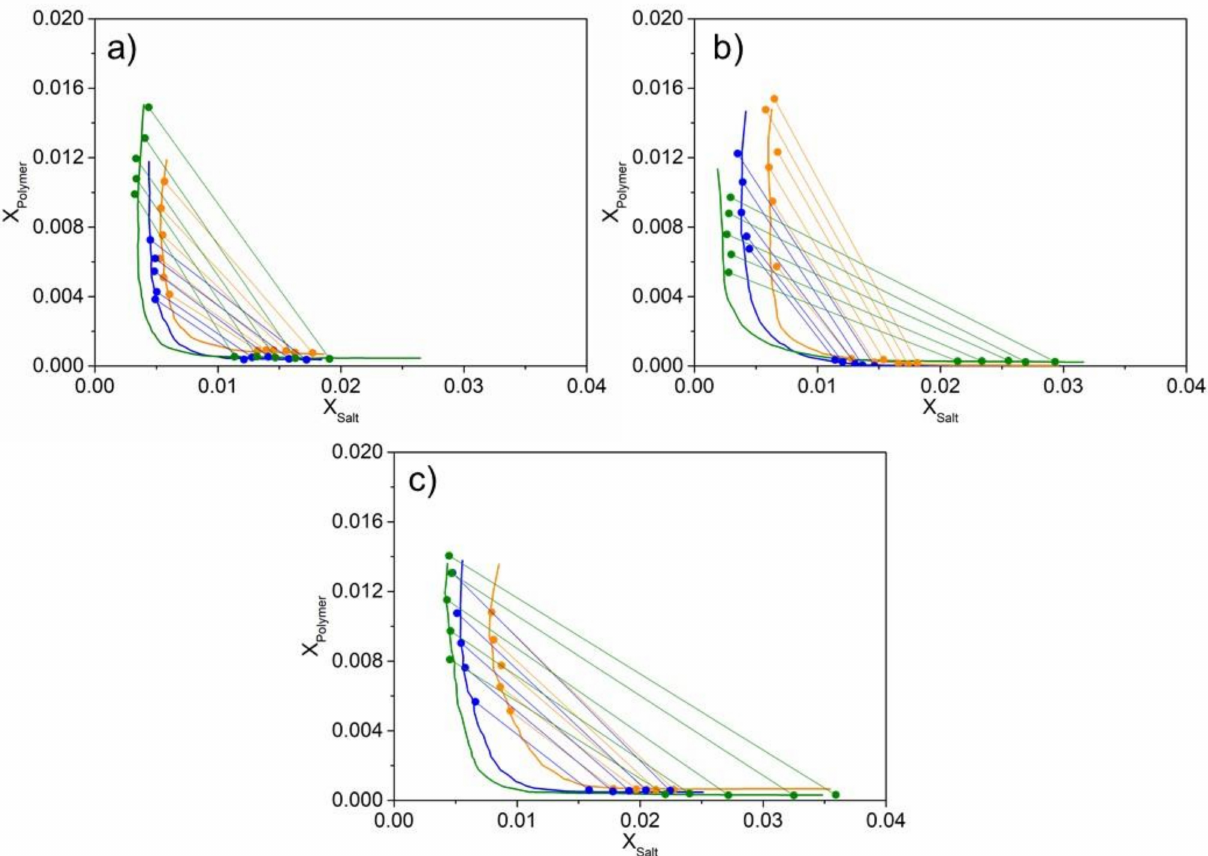
Figure 2. Binodal curves and tie lines at pH ( • ) 5.0, ( • ) 7.5, and ( • ) 10.0: ( a ) Pluronic L64 + water + sodium sulfate; ( b ) Pluronic L64 + water + sodium citrate; ( c ) Pluronic L64 + sodium water +